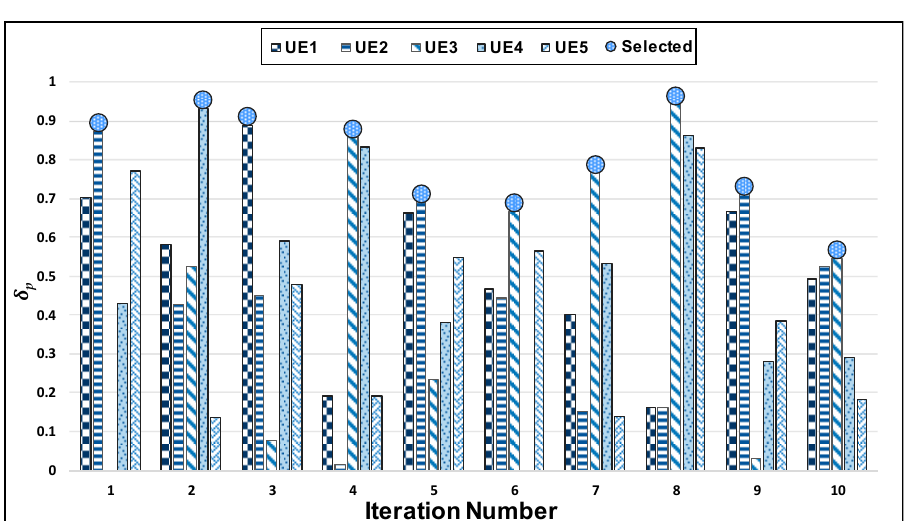
Figure 7. Selection of UE with the best ẟ p values.